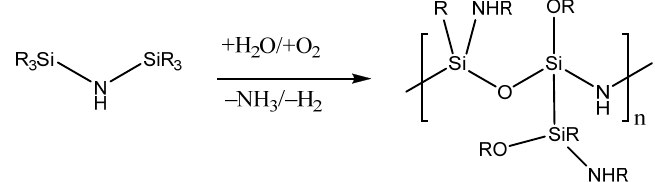
Figure 5. Hydrolysis and polycondensation reaction of Durazane 1800 in ambient atmosphere.